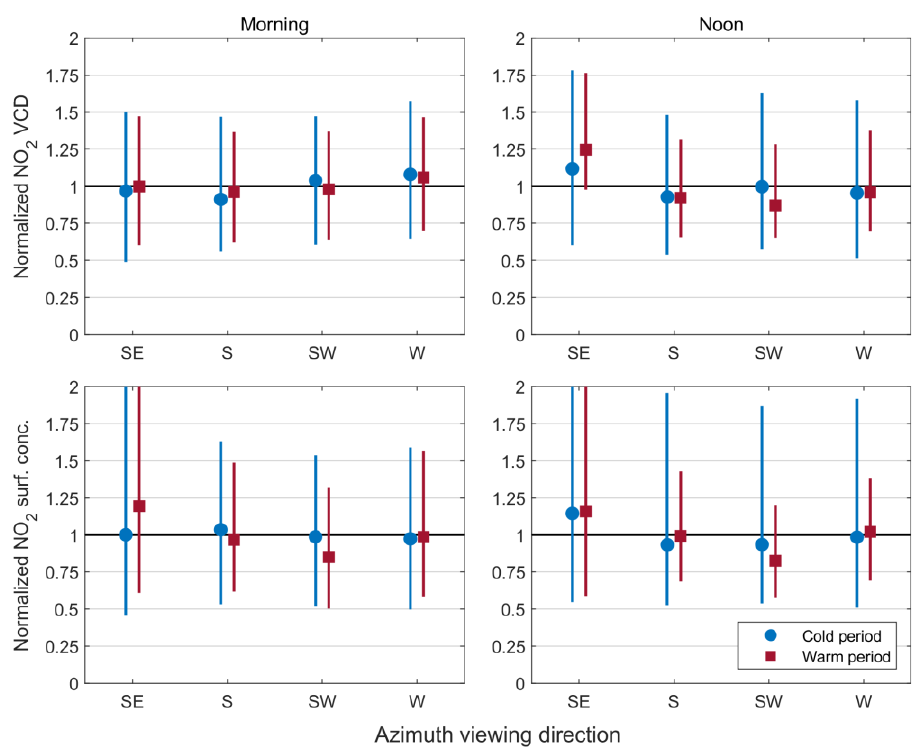
Figure 7. Distribution of the normalized MAX-DOAS measurements of NO 2 VCDs ( top row ) and surface concentrations ( bottom row ) for all azimuth viewing angles during morning ( left column ) and noon ( right column ) hours. Data are presented separately for the cold (blue) and warm (red)